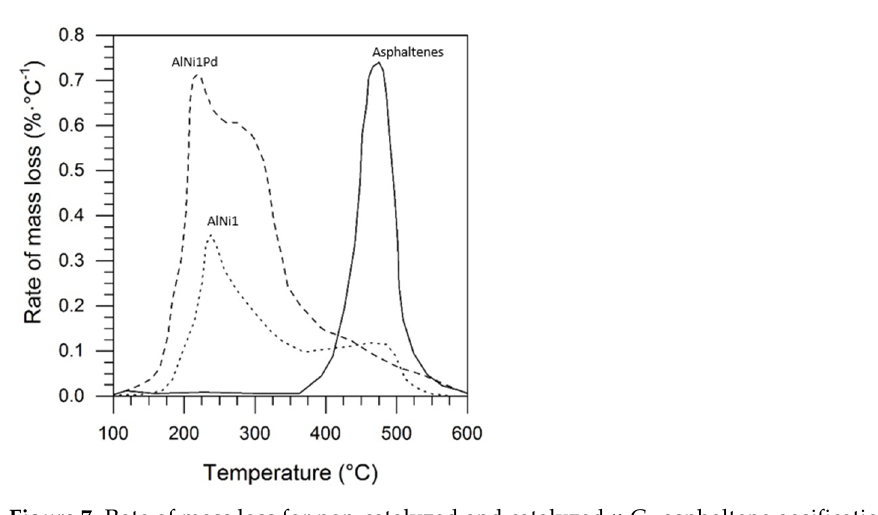
Figure 7. Rate of mass loss for non-catalyzed and catalyzed n -C 7 asphaltene gasification by AlNi1 and AlNi1Pd1 nanoparticles.